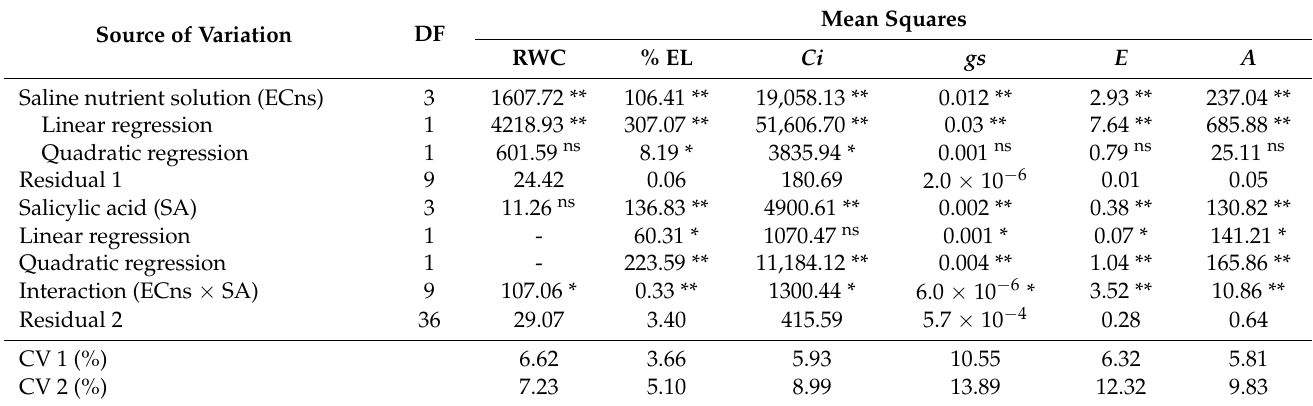
DF: degree of freedom; CV: Coefficient of variation; ns , *, and **, respectively, not significant, significant at a p ≤ 0.05 and p ≤ 0.01. The foliar application of salicylic acid (SA) up to concentrations of 2.0 mM promoted an increase in the RWC, even when plants were cultivated with the highest ECns (6.6 dS m − 1 ) (Figure 4A). The highest RWC (85.05%) was observed in plants subjected to ECns of 2.1 dS m − 1 and SA concentration of 2.0 mM, corresponding to an increase of 3.34% compared to plants cultivated with the same ECns (2.1 dS m − 1 ) and without SA application (0 mM). However, the application of SA on leaves at concentrations greater than 2.0 mM intensified the harmful effects of salt stress on RWC, and the lowest value (59.03%) was obtained in plants that received ECns of 6.6 dS m − 1 and SA concentration of 5.4 mM.